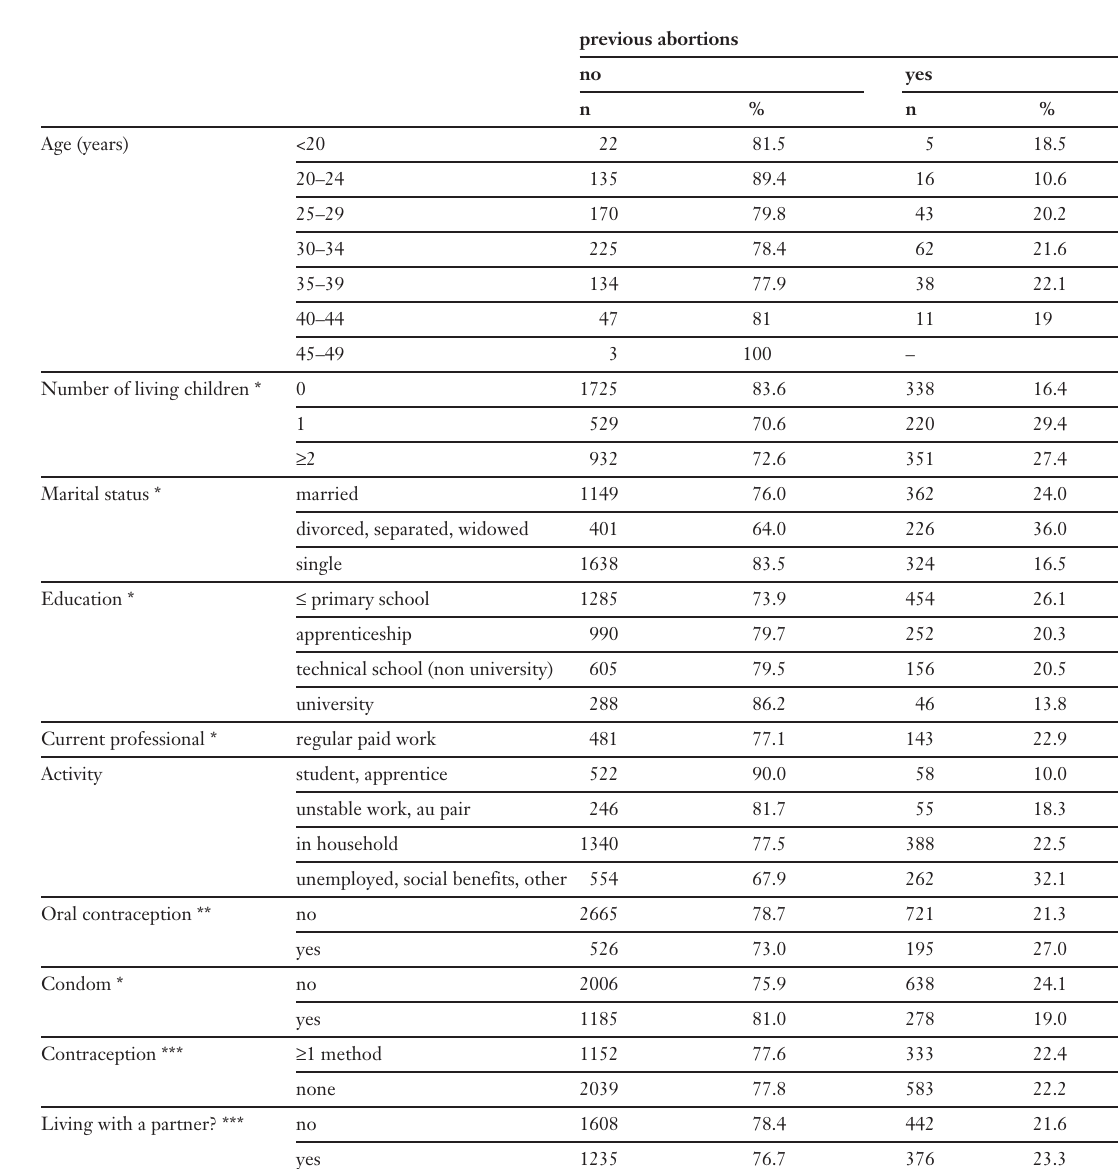
Table 3 Bivariate analyses of available determi- nants of previous abortions, Vaud